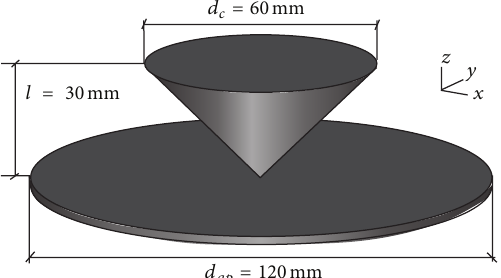
Figure 1: Conical antenna model with circular aperture.